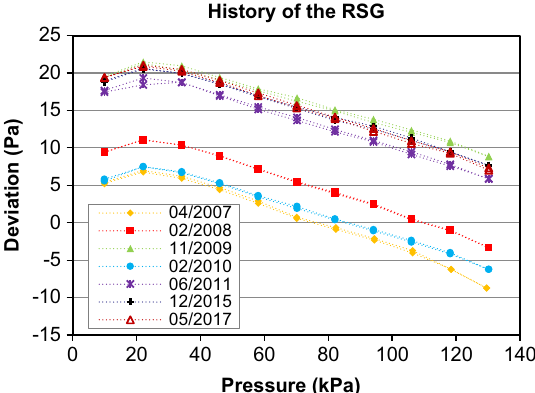
Fig. 2. Several calibrations of the upper range of the RSG by means of an absolute pressure balance. One can see at a glance, in the upper pressure range (30 – 130 kPa), that the RSG signal is linear and the slope of an applied straight correction line would be stable over time.